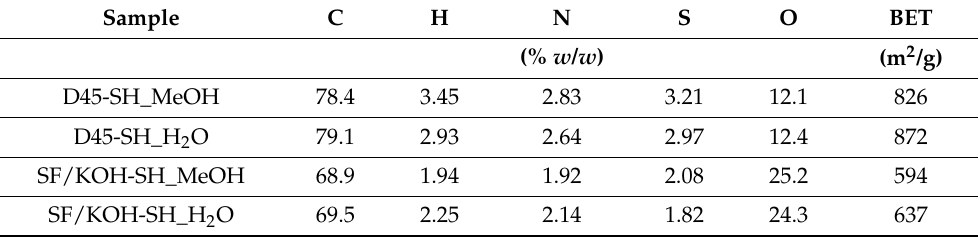
Table 2. Elemental analysis and surface area of the thiol-functionalized carbonaceous